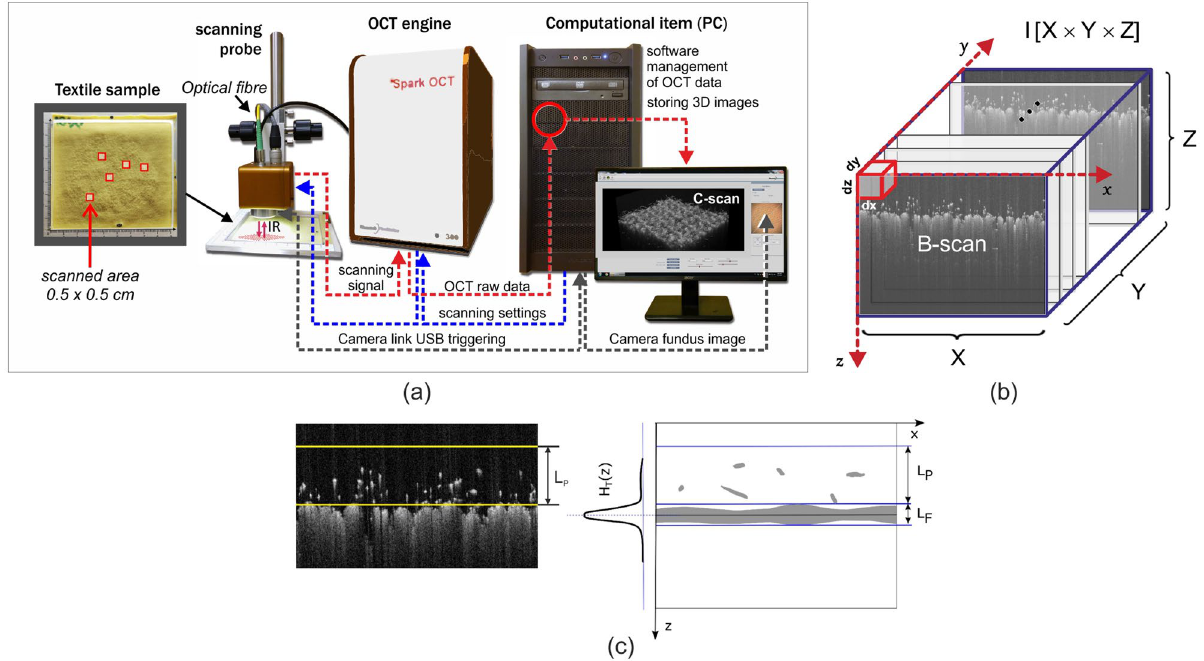
Figure 2. Acquiring information of the fabric surface. ( a ) HR-Spark OCT 1300 nm OCT setup. The engine module contains a Fourier domain (FD) Michelson’s interferometer, where interference is obtained using a short coherence light scanning source. The sample arm of the interferometer is equipped with an infrared scanning head in the OCT Scanning Probe. ( b ) Stack of acquired B-scans equivalent to OCT volumetric data. ( c ) Illustration of the layer model, applied to an OCT image of a pilling fabric. A single B-scan with fabric and pilling layers is visible. L F – fabric layer. L P – pilling layer. H T ( z ) – Hough transform in z